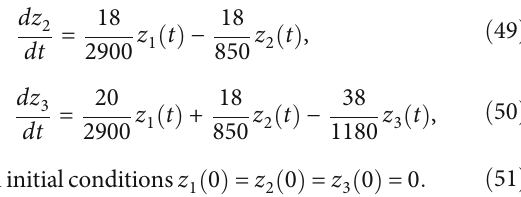
t Þ , Δ z t Þ , and Δ z t Þ 1 ð 2 ð 3 ð